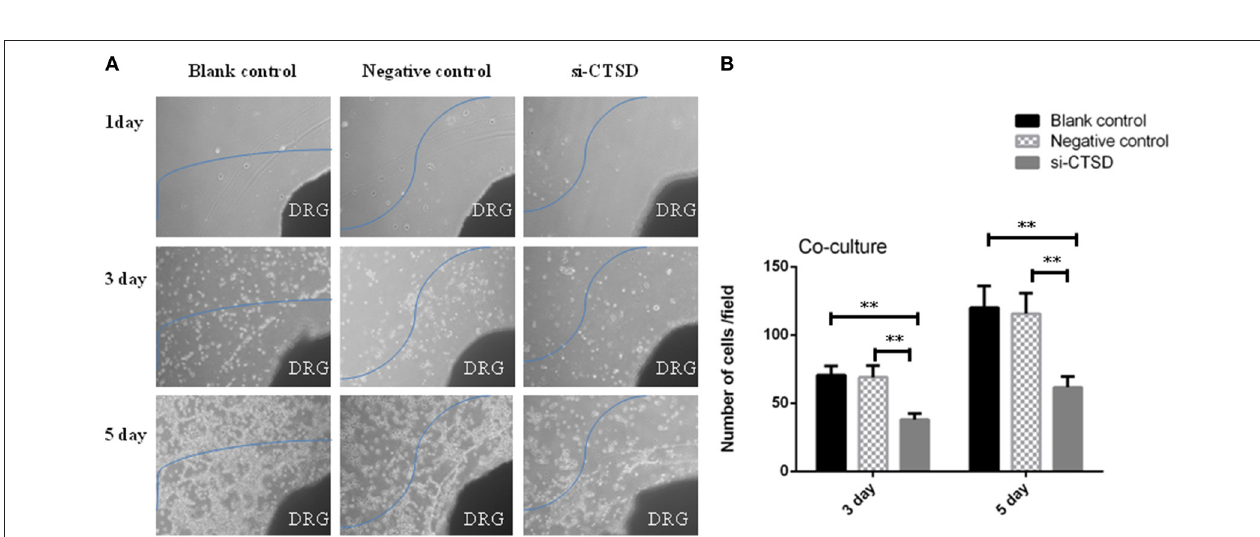
FIGURE 4 | Effect of CTSD on migration and invasion of SACC-LM cells. (A,B) Scratch wound healing assay showed that CTSD knockdown inhibited the migratory ability of SACC-LM cells, (200 × ). (C,D) Transwell invasion assay showed that CTSD knockdown inhibited the invasive ability of SACC-LM cells, (200 × ) (** p < 0.01).